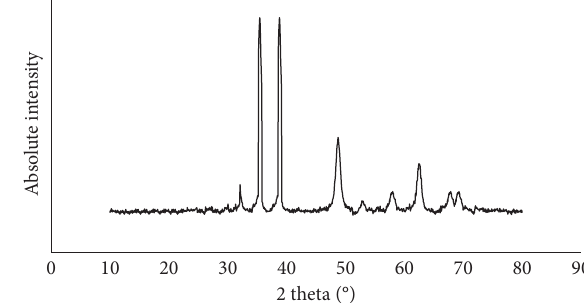
Figure 5: XRD pattern of the new nanoscale Cu (II) Schiff base